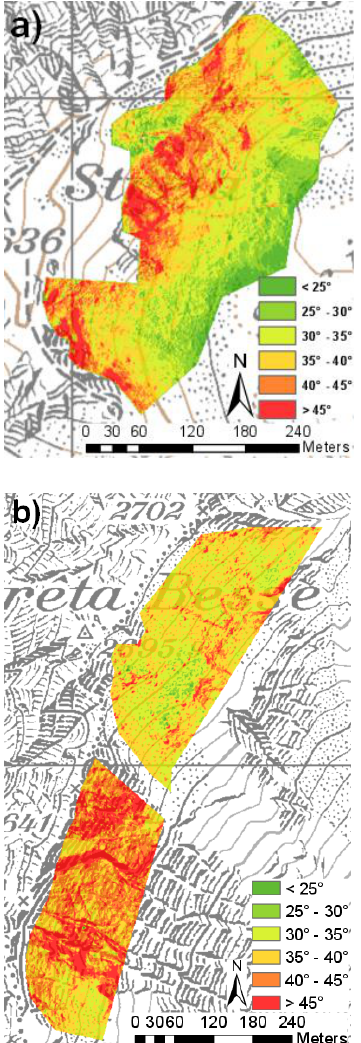
Fig. 2. Slope derived from a DTM with 1m resolution in (a) the basin of ST and (b) the basin of VdlS. Pixmaps © 2013 swisstopo Fig. 2: Slope derived from a DTM with 1m resolution in (a) (5704 000 000). the basin of ST and (b) the basin of VdlS. Pixmaps© 2013 swisstopo (5704 000 000).